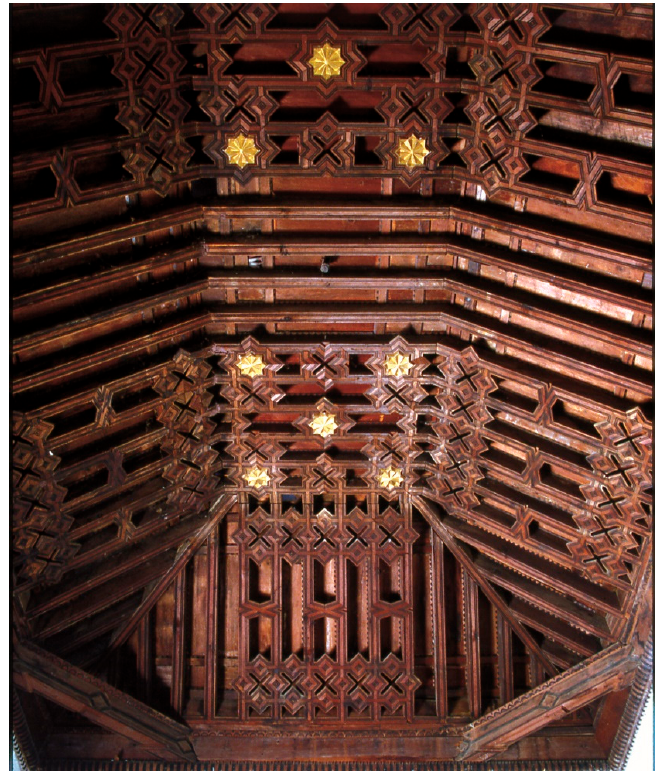
Figure 2. Sacristy ceiling of San Diego church. Huejotzingo. Photo took by author.